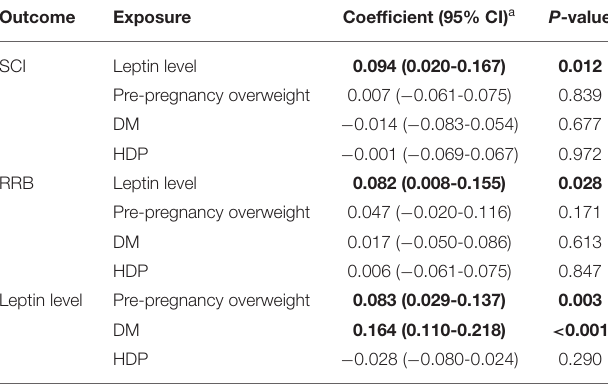
TABLE 5 | Result of the sensitivity analysis (Model